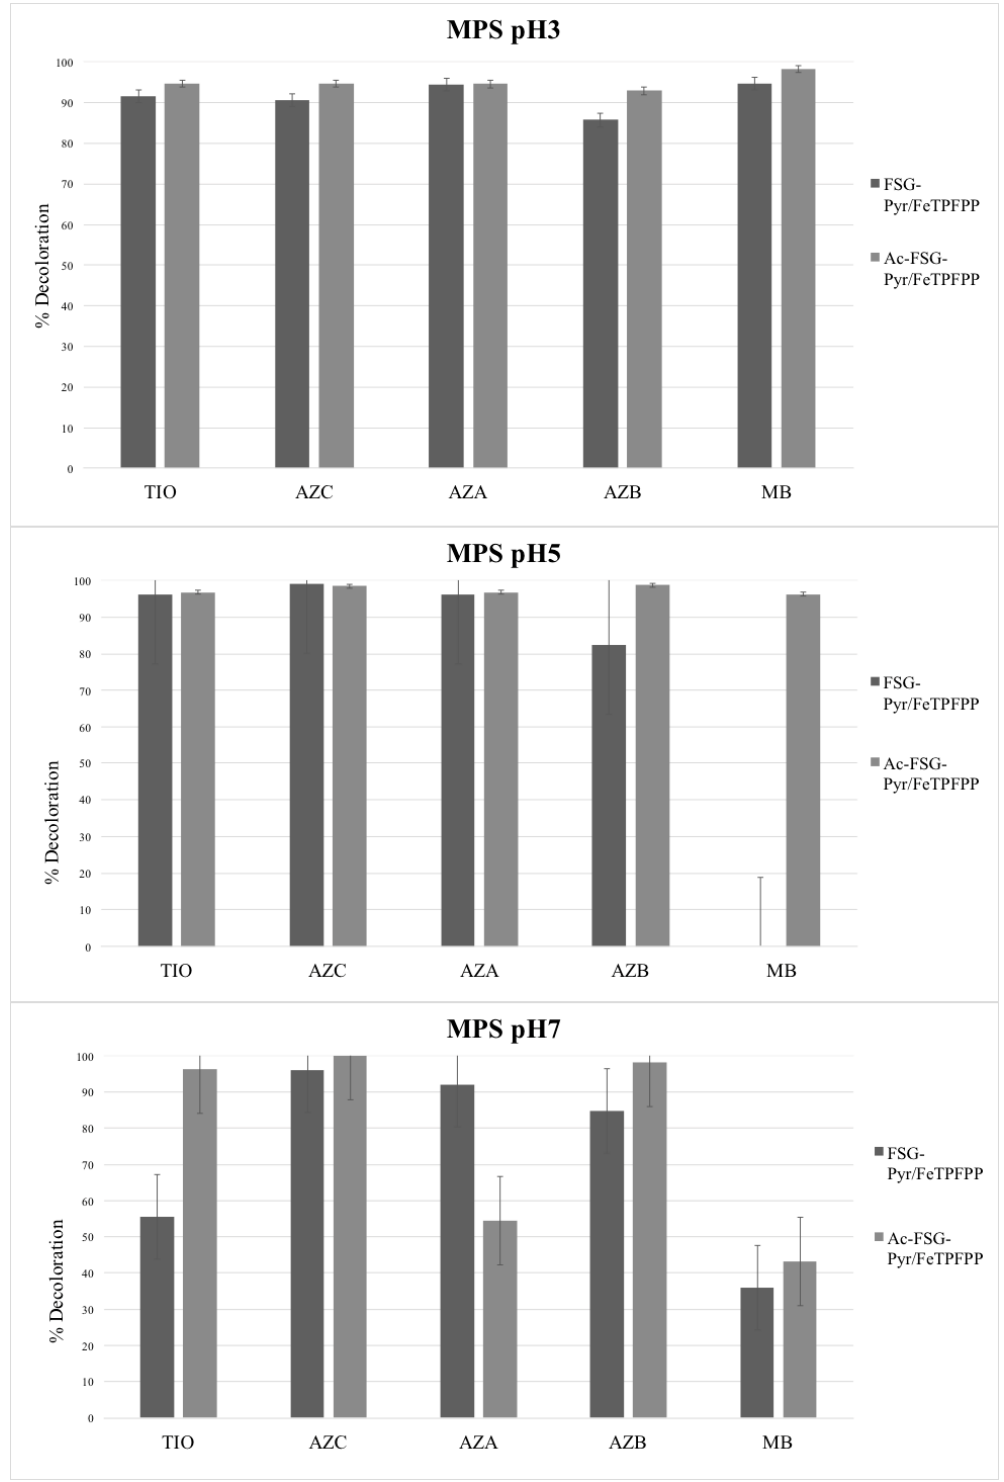
Figure 8 . Catalytic activity of the tested immobilized metalloporphyrins in the presence of potassium monopersulfate (MPS) as the oxidant at different pH values. Catalytic activity is expressed as % decolorization (i.e., % of initial absorbance at λ max which disappeared during reaction). n = 3.